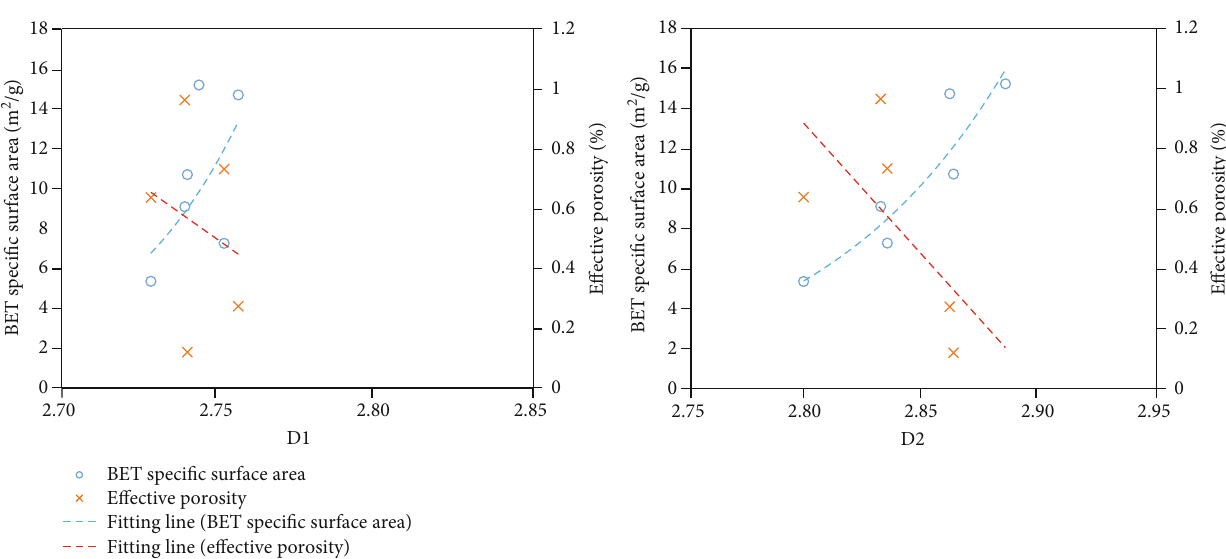
Figure 10: Relationship between reservoir property and fractal